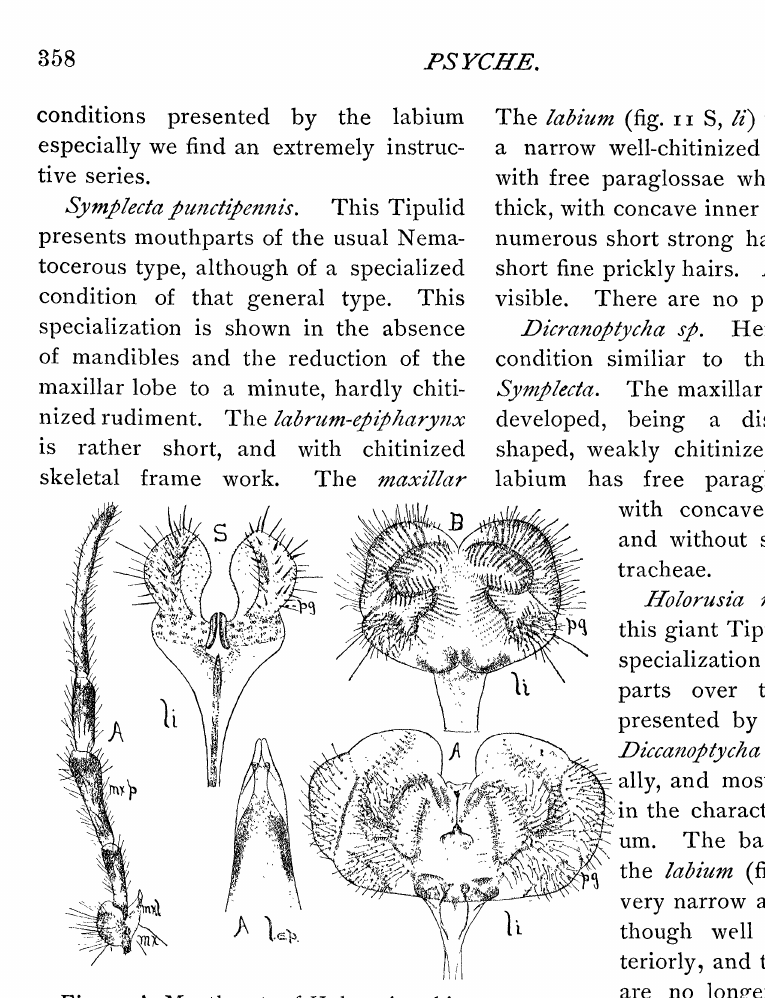
are no longer free but are Fig. II, A, Mouthparts of. Holorusia rubig fused for two-thirds of their length, inosa, 1. ej. labrum-epipharynx, rnx. max- illa, rex. 1. rnaxillar lobe, mx.p. maxillar forming a single large flat (though palpus, h’. labium, /ff. paraglossa; B,